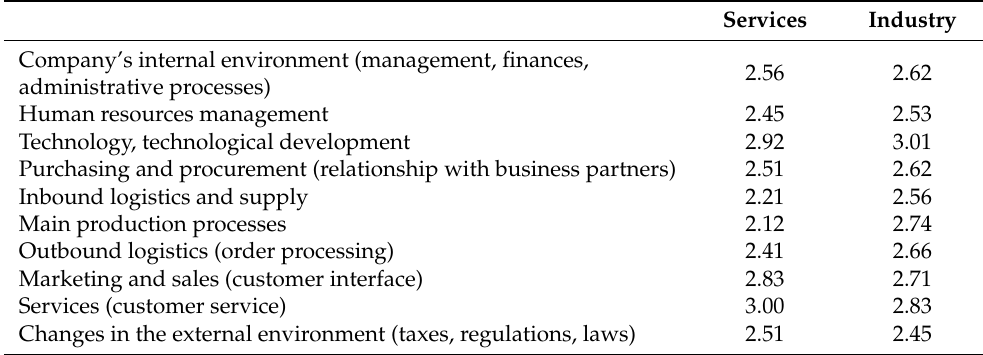
Table 4. Average assessment of expected impacts of Industry 4.0 in selected areas based on sector.